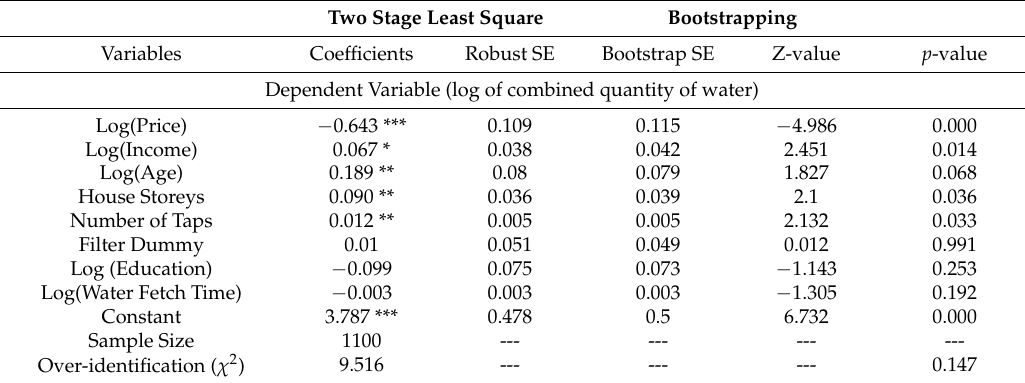
Table 3. Two-stage least square estimation of residential water demand